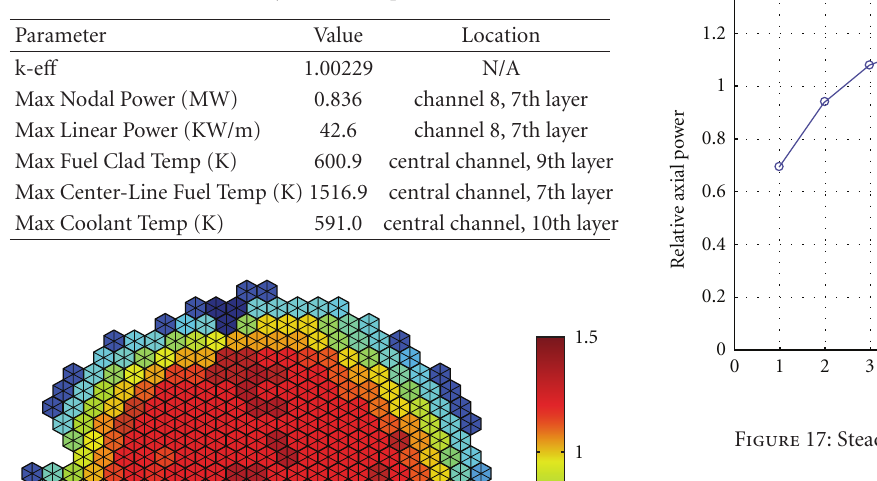
Table 16: [Steady State] core parameters.